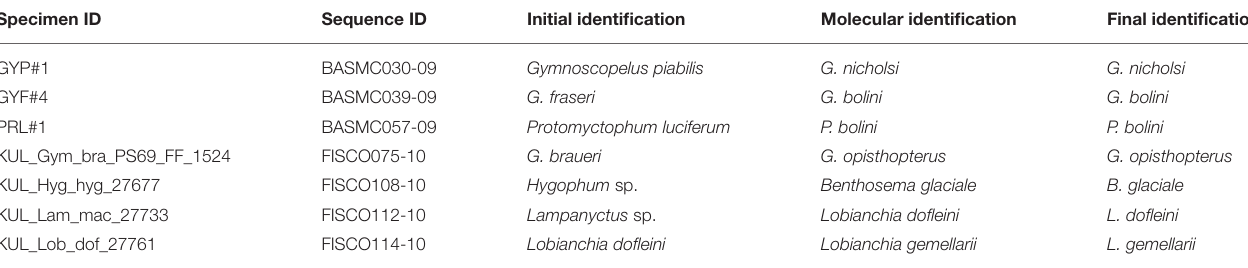
TABLE 2 | Antarctic mesopelagic fish specimens where mismatch between morphological and molecular identification led to re-identification after detailed inspection. Specimen